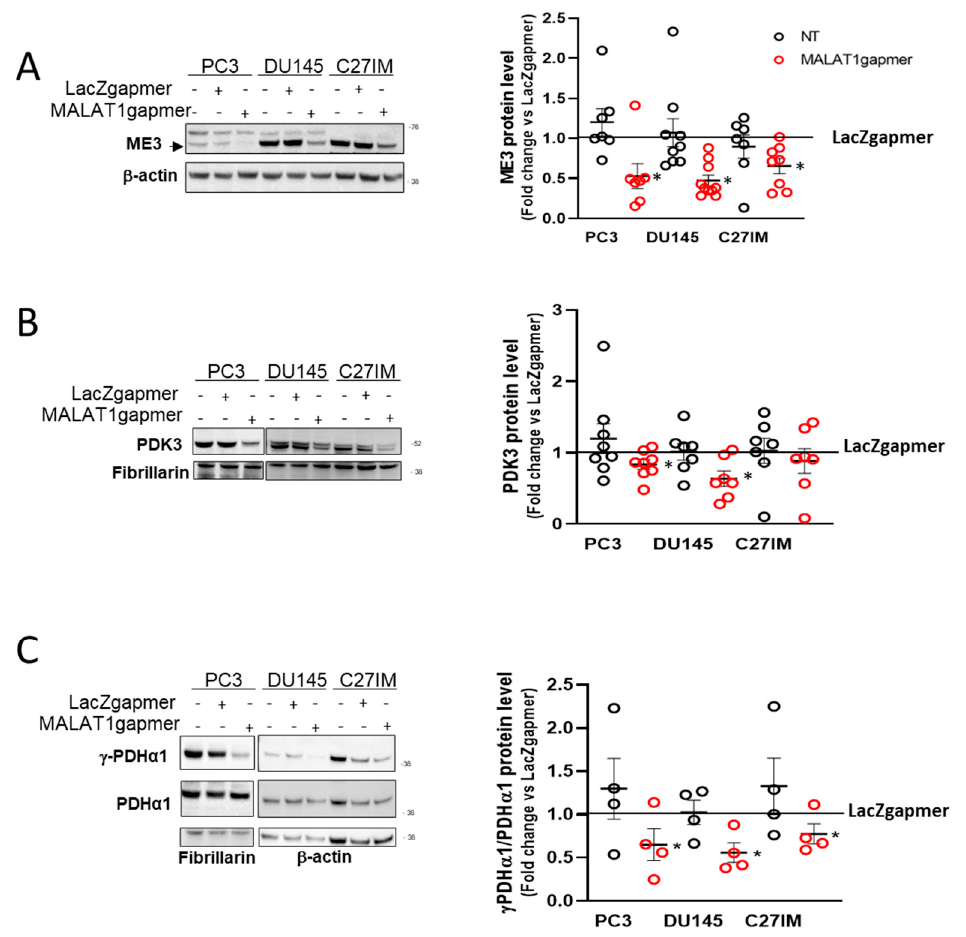
Figure 5. Validation of PCa cells array data set. ( A – C ) Representative western blot and densitometry analysis for specific metabolic enzymes assessed in 3 different PCa cells (PC3, DU145, and C27IM) not transfected or transfected with specific gapmers for MALAT1 or LacZ: ME3 (( A ), black arrow indicates specific signal), PDK3 ( B ), γ -PDH α 1, and total PDH α 1 ( C ). β -actin or fibrillarin were used as a loading control. ME3 and PDK3 protein levels were normalized versus β -actin and fibrillarin, respectively; γ -PDH α 1 versus total PDH α 1. Results are plotted as fold change vs. LacZgapmer taken as reference value 1 (straight black line). Individual values ( n = 4 to 8) with mean ± SEM are shown. Non-parametric paired two-tailed Student’s t -test determined statistical significance. * p ≤ 0.05 MALAT1gapmer vs. LacZgapmer. Uncropped Western Blots of Figure 5 are available in Figures S11–S13.